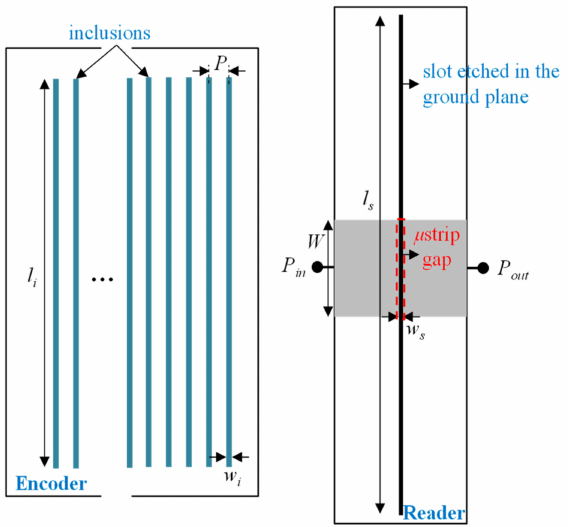
Figure 14. Topology of the reader-encoder, with encoder based on apertures or linear dielectric inclusions, and relevant dimensions (in mm). W = 3.98, l s = 24, w s = 0.2, l i = 18, w i = 0.4, and P = 3.4. Reprinted with permission from [25]. Copyright 2020